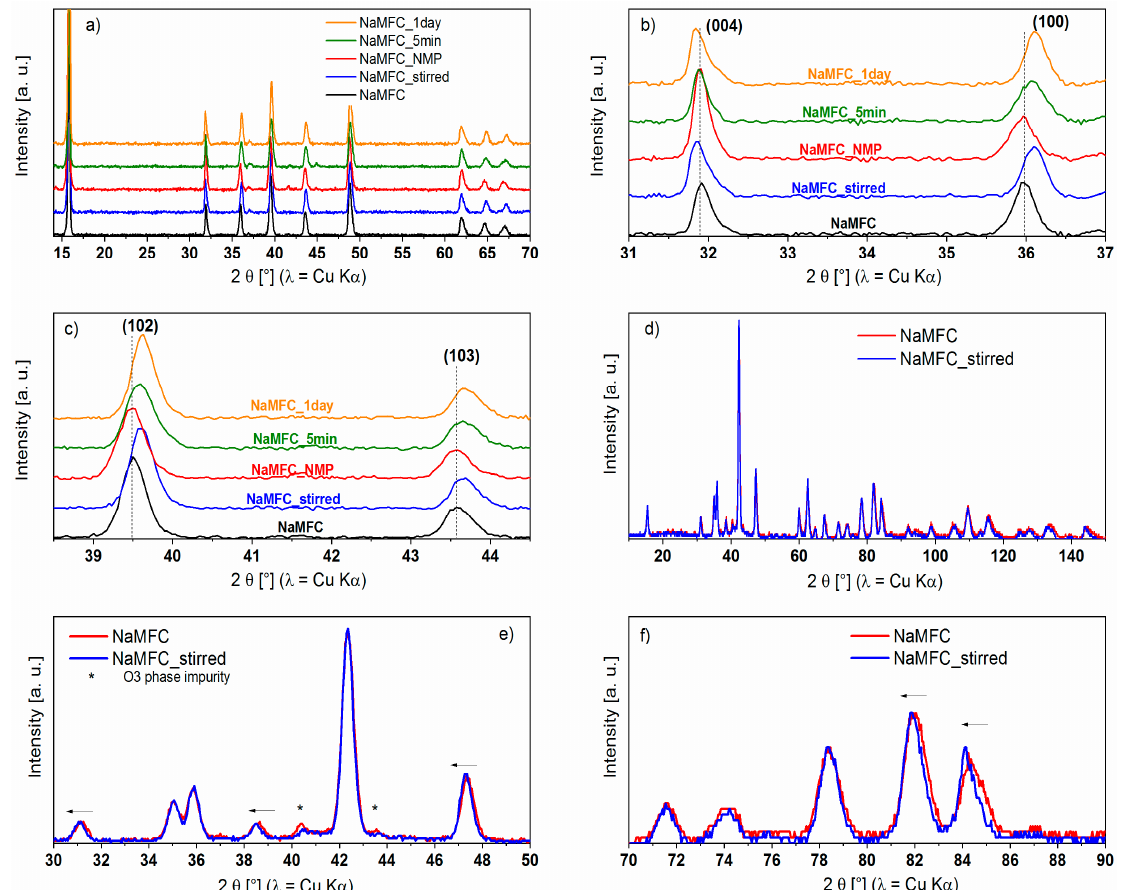
Figure 2. XRD patterns of NaMFC and NaMFC_stirred for ( a ) a full 2 θ range, ( b ) between 31 ◦ and 37 ◦ , ( c ) between 38.5 ◦ and 44.5 ◦ ; Neutron diffraction patterns of NaMFC and NaMFC_stirred for ( d ) a full 2 θ range, ( e ) between 30 ◦ and 50 ◦ , ( f ) between 70 ◦ and 90 ◦ . Table 3. Cell parameters of the P2 phase (P6 3 / mmc ) NaMFC and NaMFC_stirred refined following the Lebail method using the neutron diffraction data.